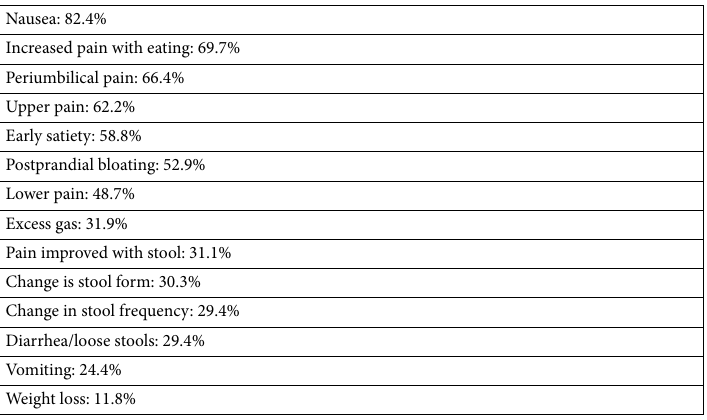
Table 1. Symptom frequencies in APP patients evaluated in the abdominal pain program.